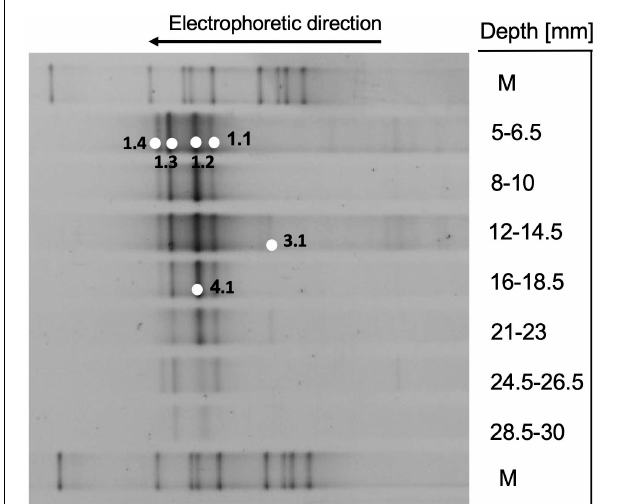
FIGURE 8 | DGGE analysis of methyl-coenzyme M reductase alpha subunit genes